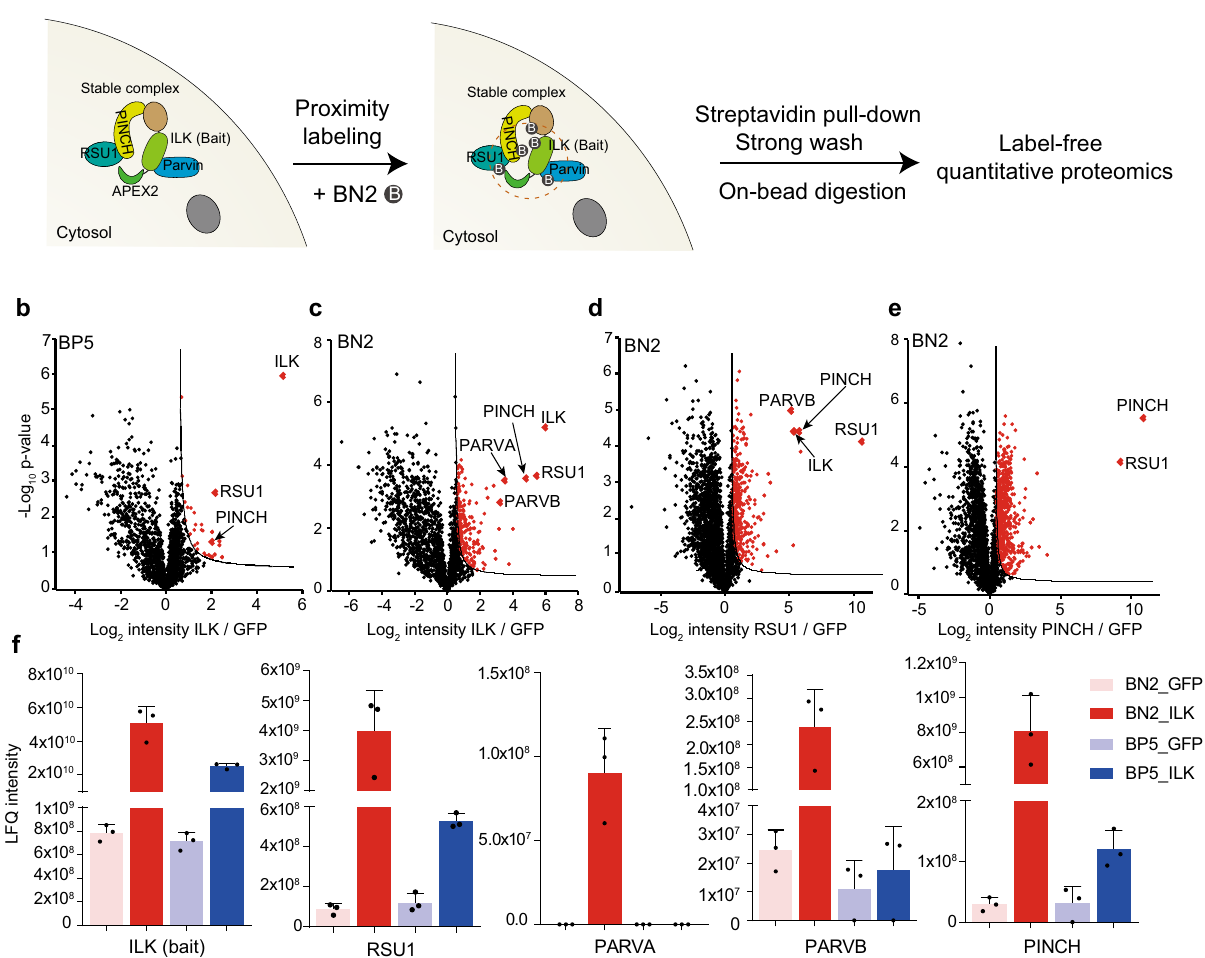
Fig. 3 Highly selective proximity proteomic analysis of stable protein complex in cytosol. a Scheme of BN2-based proximity proteomic analysis in living cells. The well-characterized stable ILK-PINCH-PARVIN-RSU1 protein complex are shown (insert). b , c Volcano plot comparison between BP5- and BN2- based proximity proteomic analysis with stably expressed APEX2-FLAG-ILK in HT1080 cells as the bait protein ( n = 3 independent biological experiments). d , e Reciprocal BN2-based proximity proteomic analysis of RSU1 ( d ) or PINCH ( e ) interactome. Stably expressed GFP was used as control in b – e. Signi fi cantly changed proteins in b – e were highlighted in red (FDR < 0.05 and S0 = 0.5). f LFQ intensity comparison of the ILK-PINCH-PARVIN-RSU1 complex proteins identi fi ed by the BP5- and BN2-based proximity proteomic analysis with ILK as bait protein. Each dot represents the indicated data of one independent experiment. Data are presented as mean values ± s.d. Error bars represent s.d. ( n = 3 independent biological experiments). Source data are provided as a Source Data fi